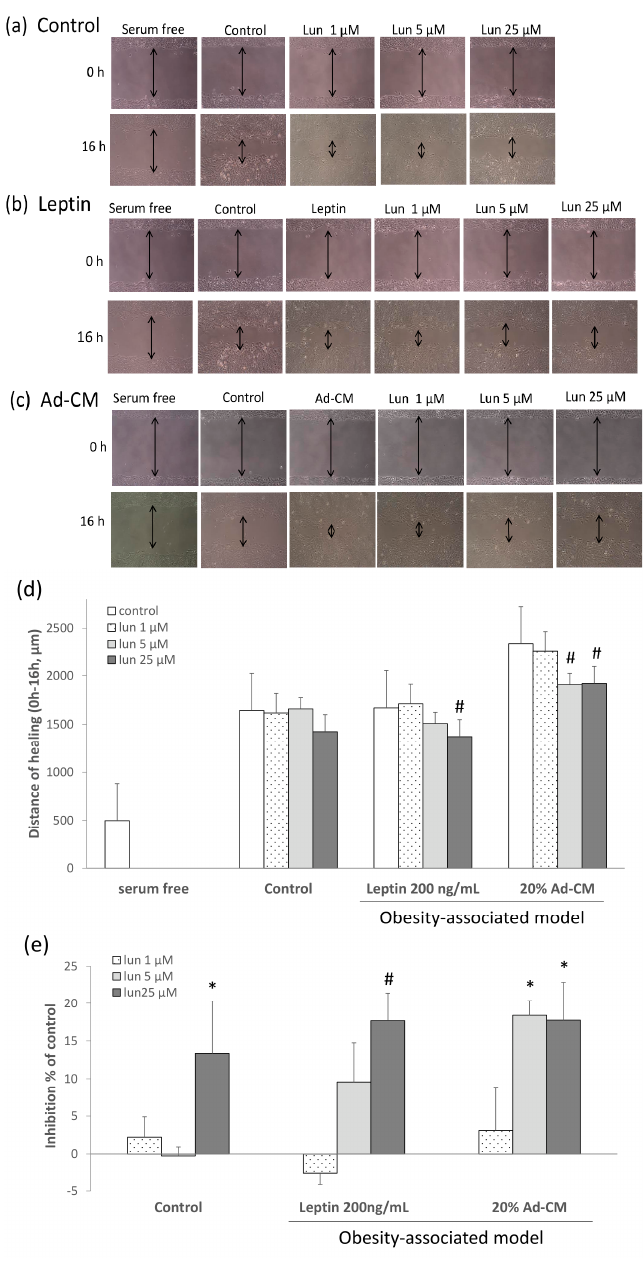
Figure 2. Effect of lunasin on breast cancer 4T1 cell metastasis. Migration patterns were observed in the scraped area of 4T1 cells treated with or without lunasin for 16 h and incubated under three conditions: ( a ) Fresh medium-5% fetal bovine serum/Dulbecco’s modified Eagle’s medium (FBS/DMEM), the mark of double arrows was present the distance of healing in the pictures; ( b ) Leptin at 200 ng/mL in 5% FBS/DMEM; ( c ) 20% Ad-CM in 5% FBS/DMEM; ( d ) The distance of migrated cells was quantified by manual counting under the microscope scale; ( e ) Migrated cells were quantified by manual counting under the microscope and presented as a percentage of inhibition relative to that of control (control as 0%). Data are shown as mean ± SEM. Statistical analysis was tested by one-way ANOVA and then Fisher’s LSD test; significant differences are presented as * p < 0.05, or # p < 0.01 versus control group.